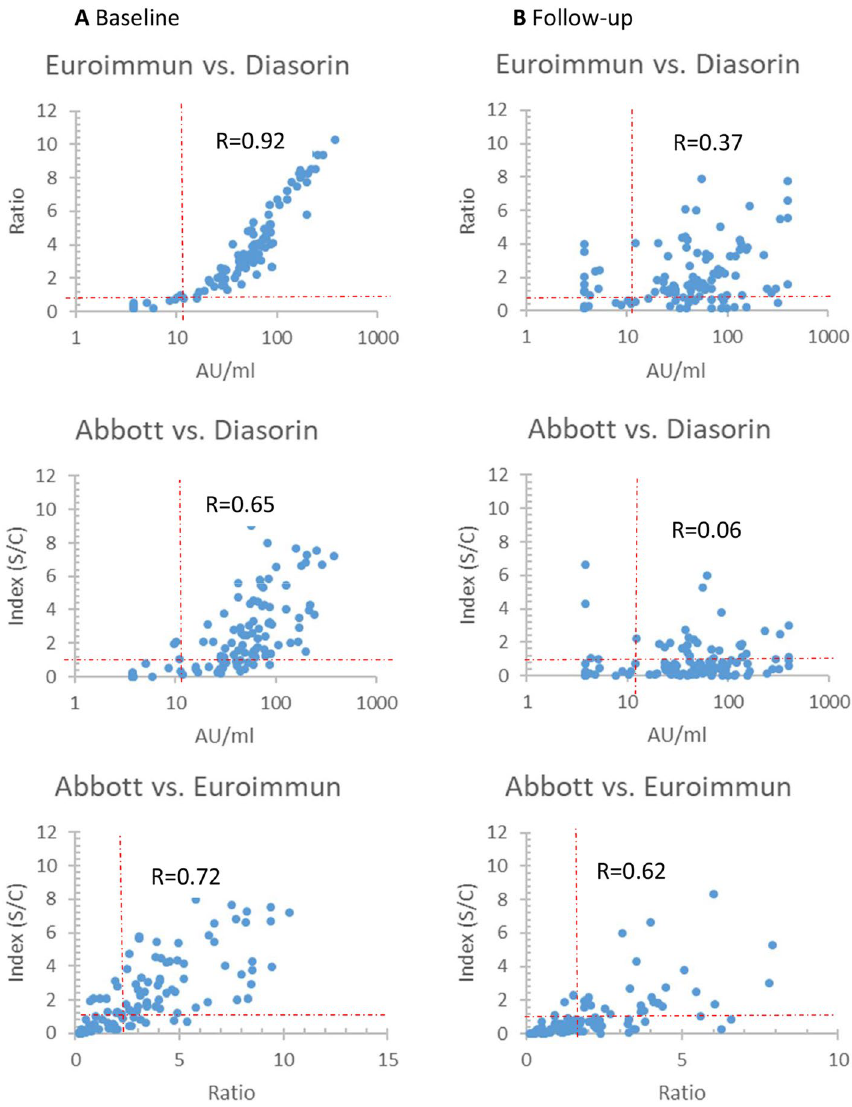
Figure 1. Relationship between levels of antibodies in different assays A at baseline and B at follow-up. Dotted lines representing the cut-off values of the assays. R Spearman’s Rank correlation coefficient.